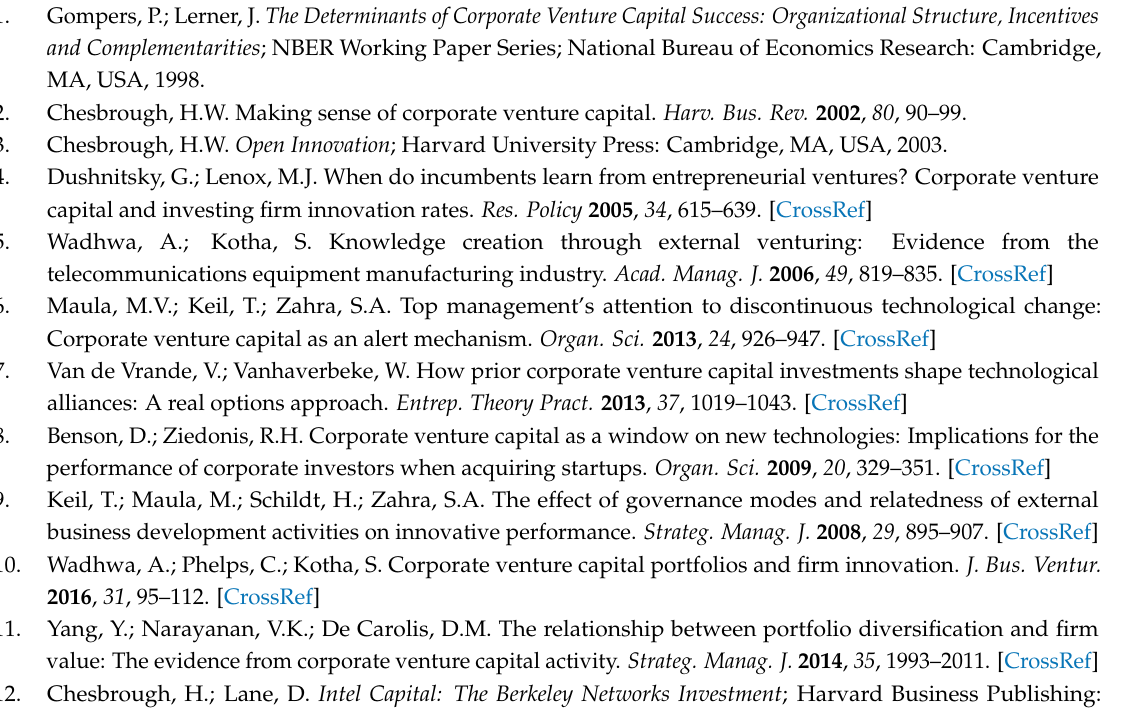
Table S1: Correlation matrix of variables with descriptive